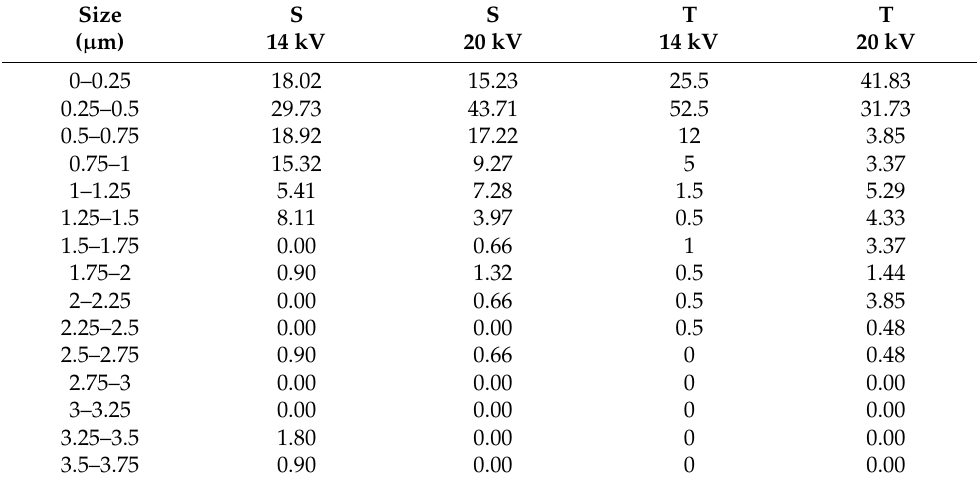
Table 3. Size distribution of microspheres from sage and thyme microemulsions electrospun at 14 kV or 20 kV.